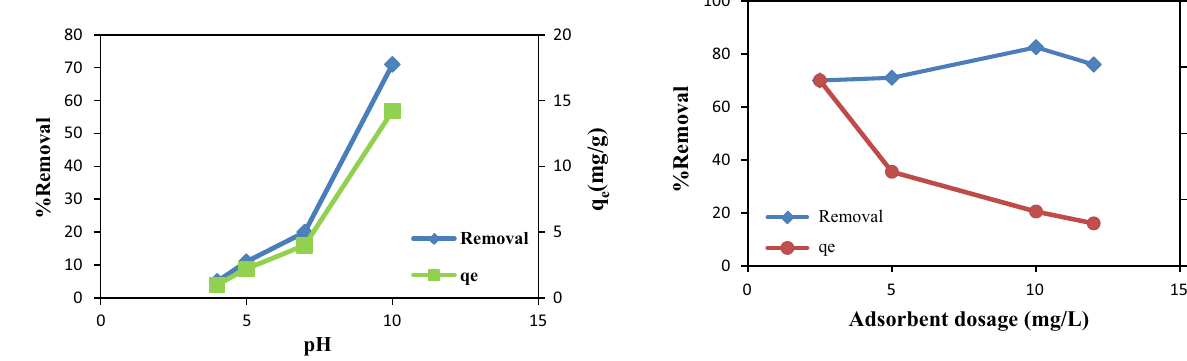
Fig. 1 Effect of initial pH on Ni(II) adsorption onto MWCNTs. (Time 5 min, dosage 5 mg/L, nickel concentration 50 mg/L)